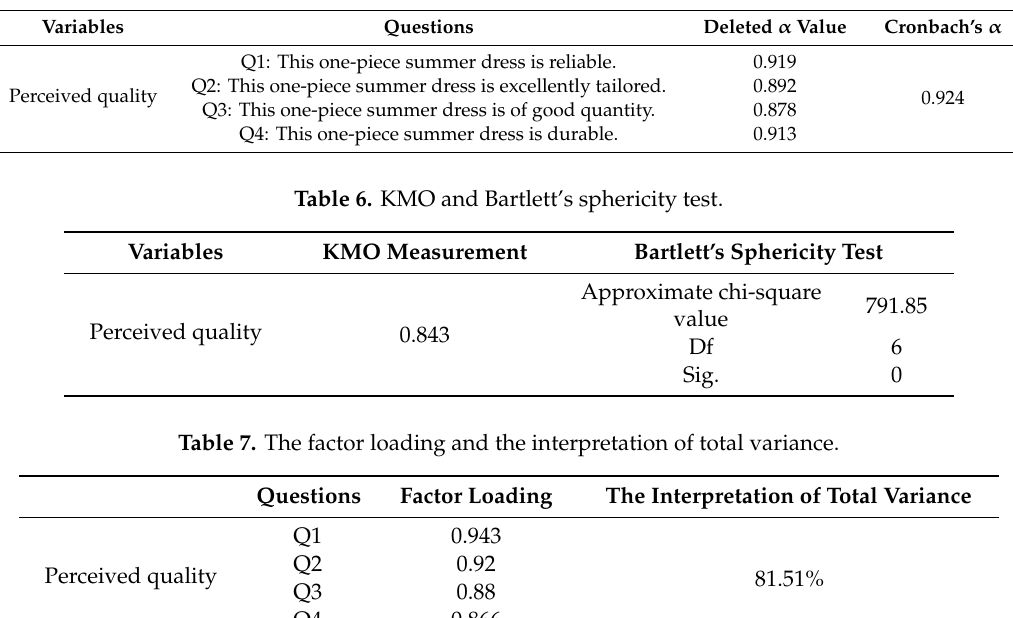
Table 5. Analysis of the reliability of perceived quality.